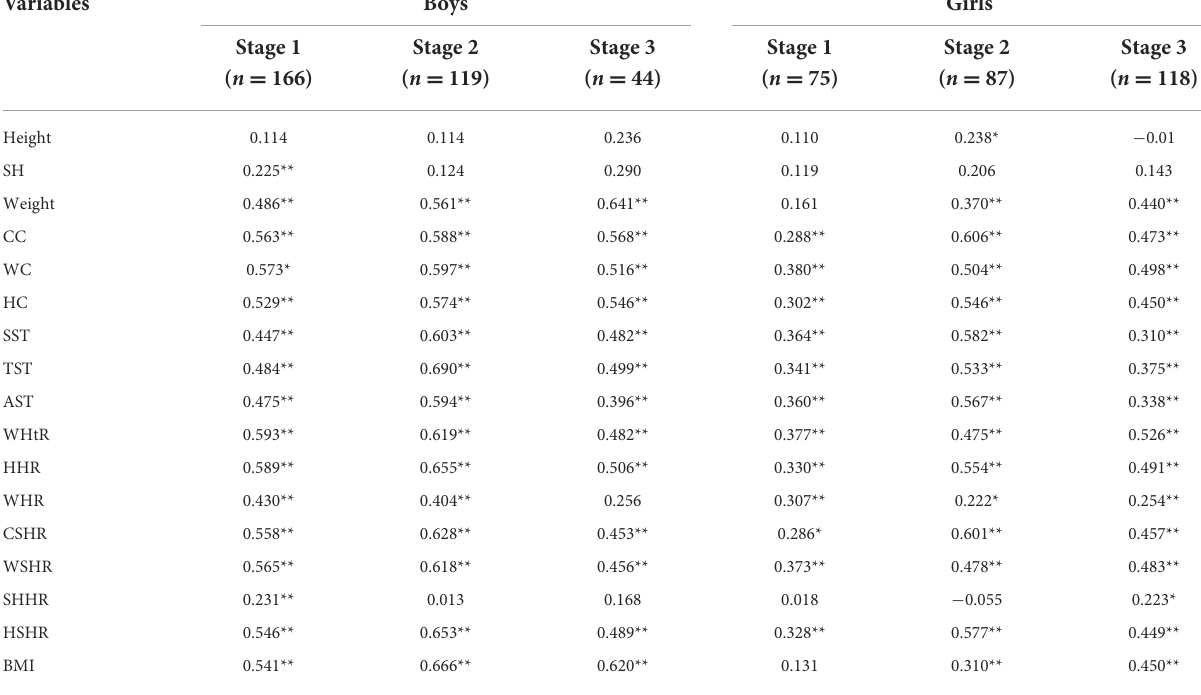
TABLE 2 Pearson correlation coefficients of associations between body anthropometric indices and BSQ score. Variables